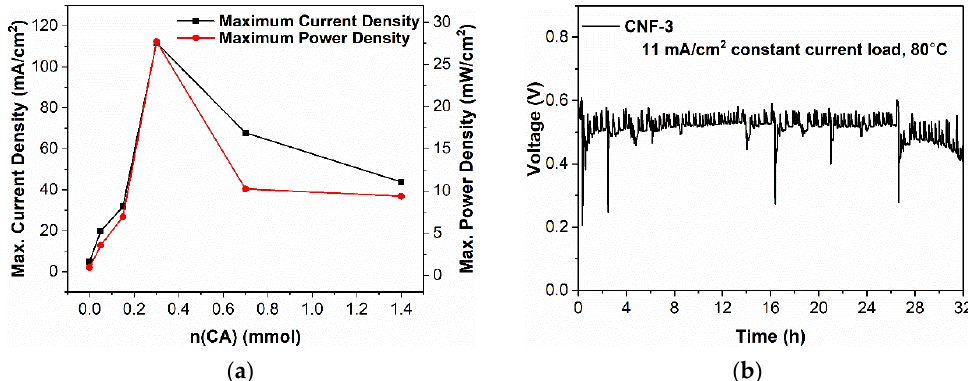
Figure 11. ( a ) Trend of maximum current density and power density with citric acid addition. ( b ) 24 h constant current density load durability test.